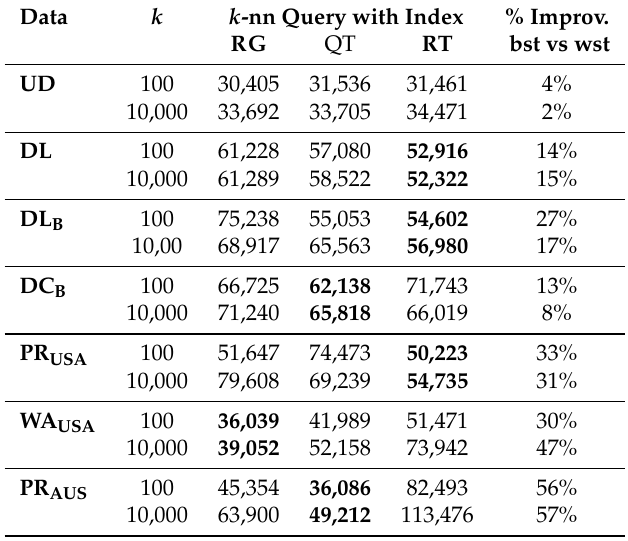
Table 9. Result of experiments with k -nn queries. we performed experiments on each listed dataset, considering k equal to 100 and 10,000. The reported time is in milliseconds and is an average value over about 20 queries for each